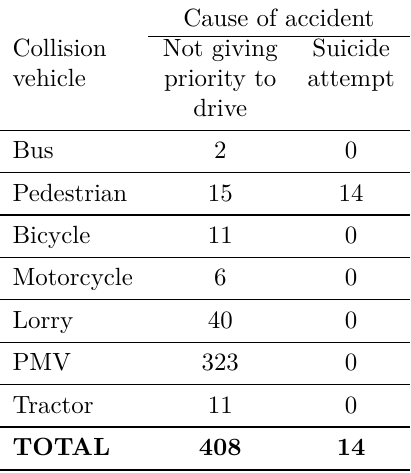
Table 2. Evaluation of accident statistics, collision vehicle vs. cause of the accident.